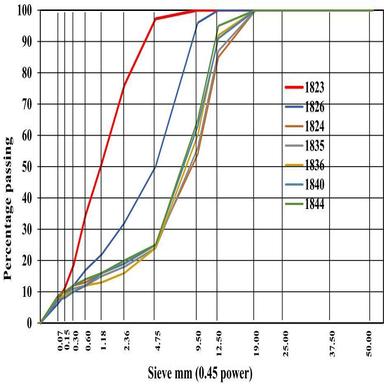
Aggregate gradation of the mixtures.